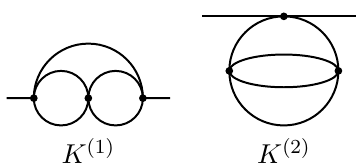
Figure 1 . Contractions of scalar quartic interactions in (3.3) that correspond to three-loop leg corrections.